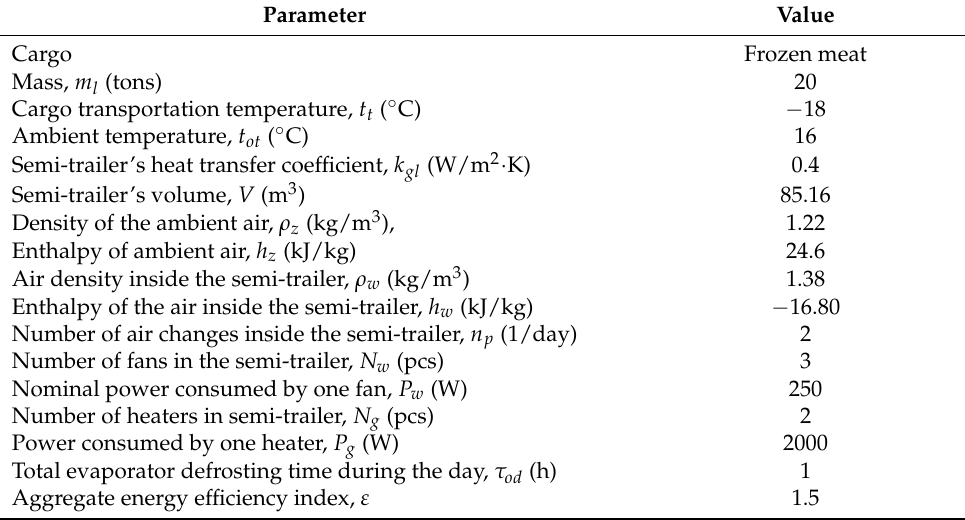
Table 2. Input data for calculations of semi-trailer heat balance.